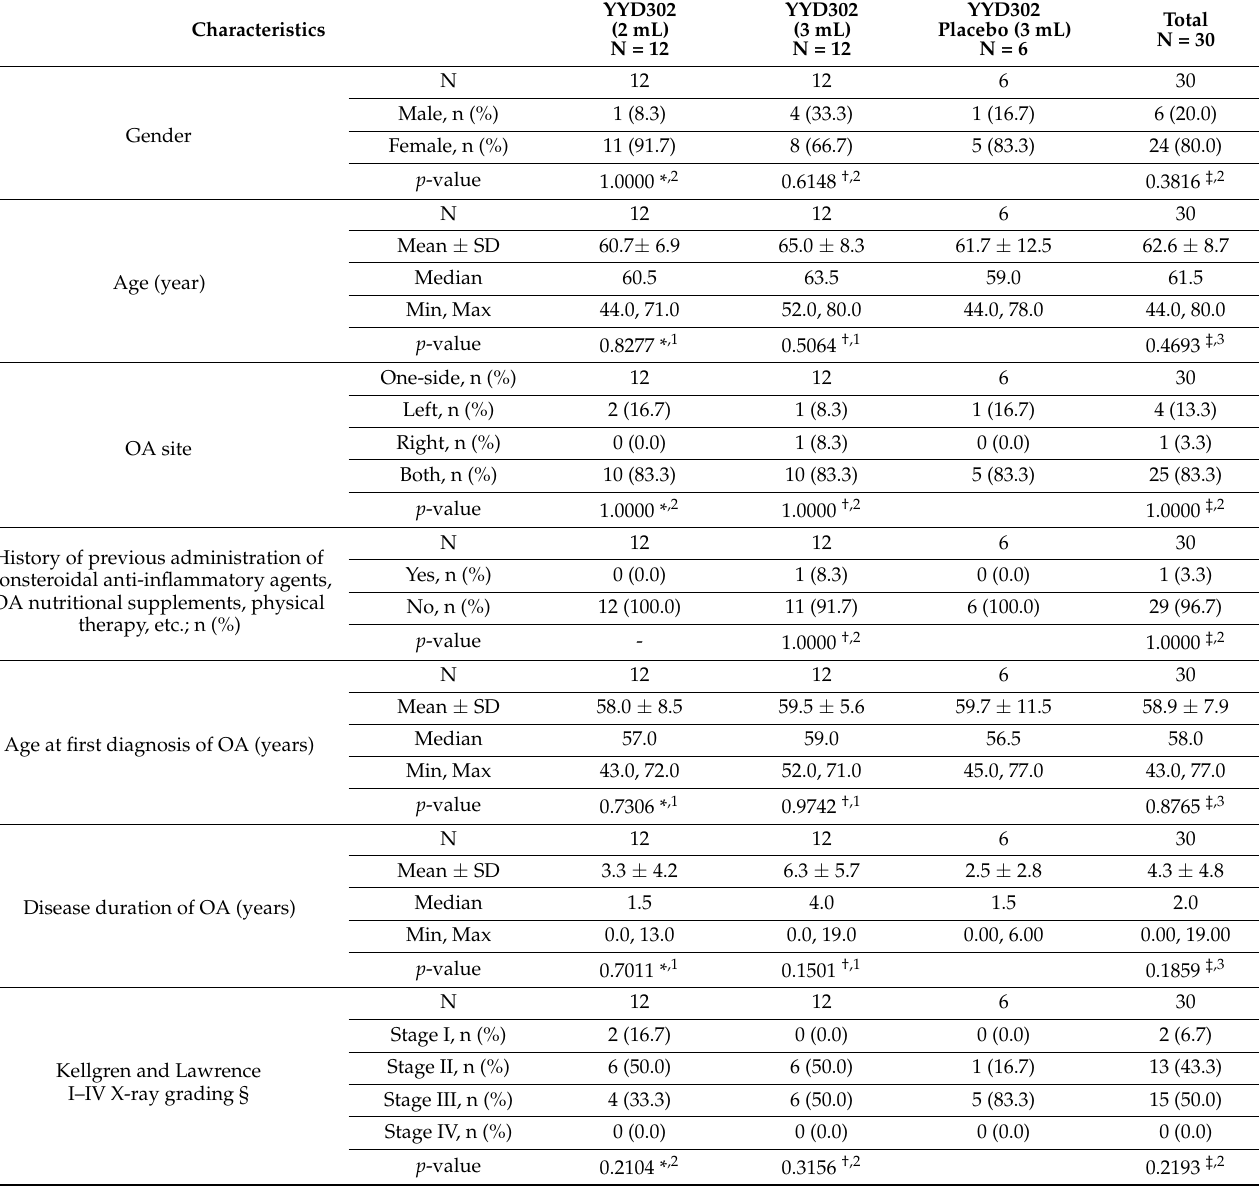
Table 1. Demographics and clinical characteristics (randomized